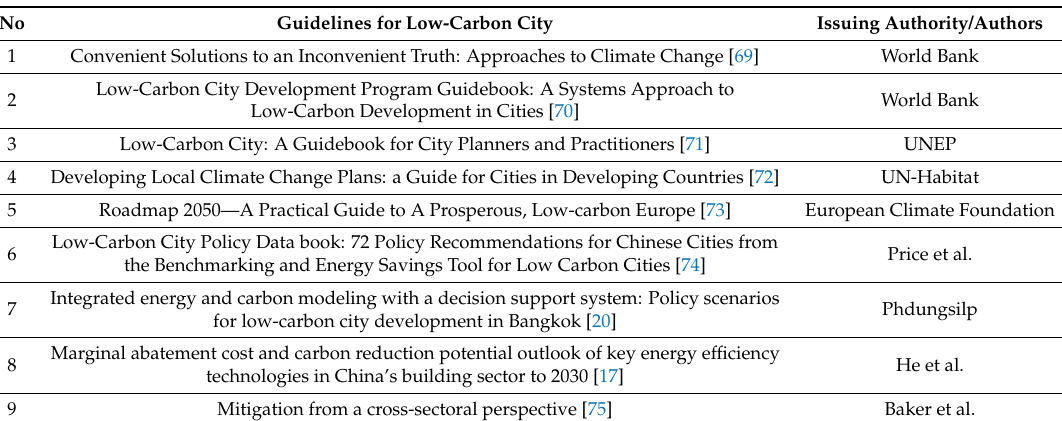
Table 9. Guidelines for promoting low-carbon